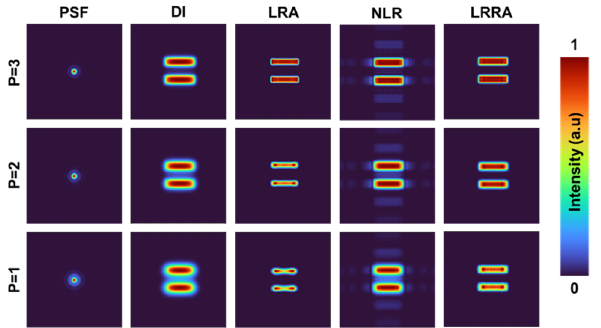
Figure 5. Images of the simulated PSF, DI of the test object, reconstruction results using LRA, NLR and LRRA.